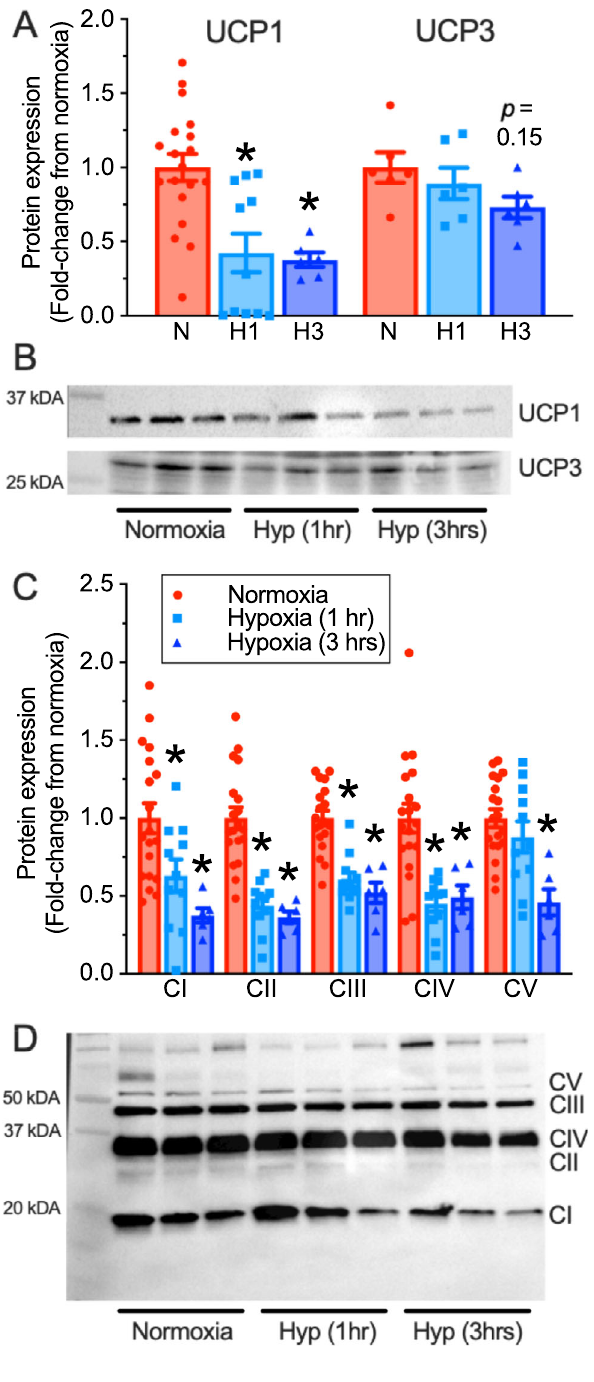
Fig. 4 Thermogenic and oxidative phosphorylation protein expression decreases in acute hypoxia. A Summary of uncoupling protein-1 (UCP1) and uncoupling protein-3 (UCP3) expression in interscapular brown adipose tissue (iBAT) from naked mole-rats treated in normoxia (21% O 2 , red bars; n = 18 and 6 biologically independent samples for UCP1 and UCP3, respectively), or 1 or 3 h of hypoxia (7% O 2 , light and dark blue bars, respectively; n = 11 and 6 biologically independent samples for UCP1 and 6 for each time point for UCP3). B Western blot images of UCP1 and UCP3 protein bands from ( A ). C Summary of electron transport chain (ETC) complexes I – IV (CI – CIV) and F 1 F o -ATPase (CV) protein expression in iBAT from naked mole-rats treated as in ( A ). D Western blot image of ETC complexes I – IV and F 1 F o -ATPase protein bands. Data are mean ± SEM. Asterisks indicate signi fi cant difference from normoxic controls (one-way ANOVA with Dunnett ’ s multiple comparisons test; F 2,33 = 10.96, p = 0.0002 for UCP1; F = 60.90, p < 0.0001 for ETC proteins; p > 0.05 4,165 for other proteins). Additional abbreviations: N – normoxia, H1 – 1 h hypoxia, H3 – 3 h hypoxia. Source data are provided as a Source Data